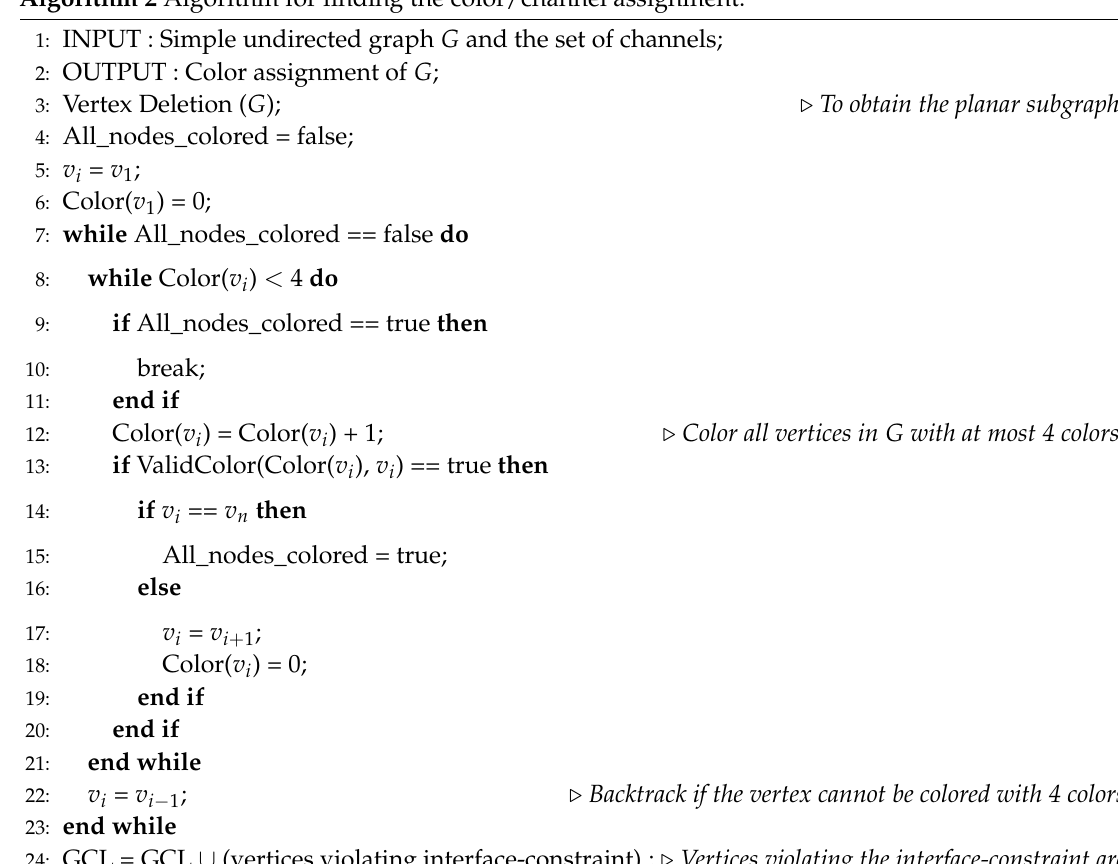
Algorithm 2 Algorithm for finding the color/channel